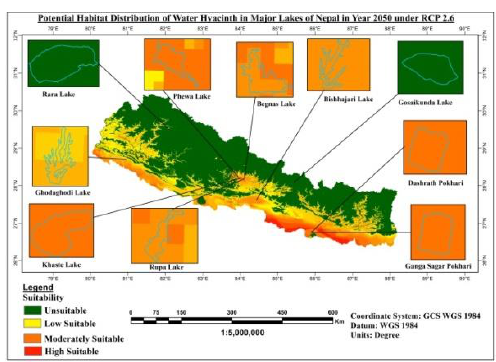
Figure 9. Potential Habitat Distribution of Water Hyacinth in Major lakes of Nepal in year 2030 under RCP 8.5